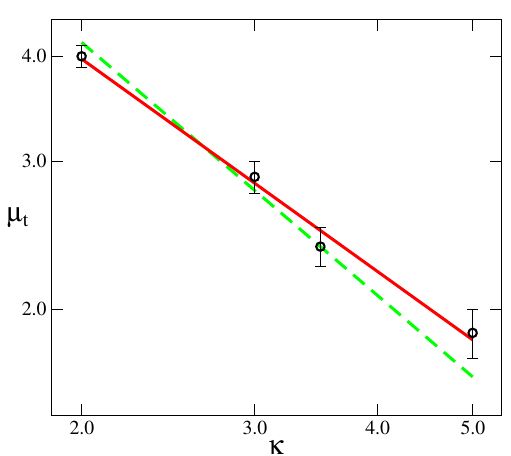
Figure 3. Relationship between the orientational coupling at the I-N transition, µ t , and the degree of flexibility, parametrized by κ , obtained by Monte Carlo simulations (symbols) at N = 24. Green (dashed) line is the mean field prediction in the limit of very large N, µ t ∼ κ − 1 . The red (continuous) line is a fit to a power law µ t ∼ κ − α , with exponent α ≈ 0.84 ± 0.05.